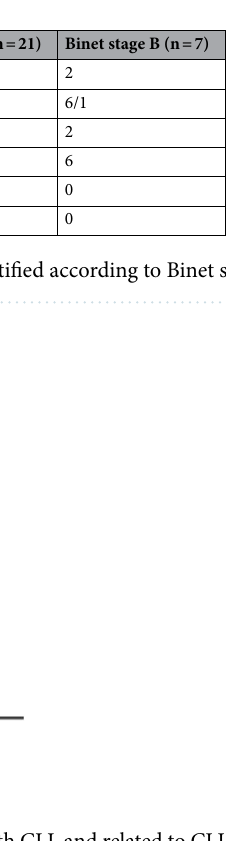
Figure 1. Plasma TFPI concentration increased in patients with CLL and related to CLL progression. Increased plasma TFPI level was observed in CLL patients compared to healthy controls. Compared to the patients with Binet stage A and B, the patients with Binet stage C showed the highest TFPI concentration in the plasma. Binet stages represent the severity of organ infiltration. Data are presented as dot plots and columns represent median levels. Concentrations are expressed as ng/mL. p values in the graph represent differences vs. controls. *p < 0.05, **p < 0.01. All statistical comparisons were adjusted for age using UNIANOVA with Bonferroni adjustment on log transformed TFPI